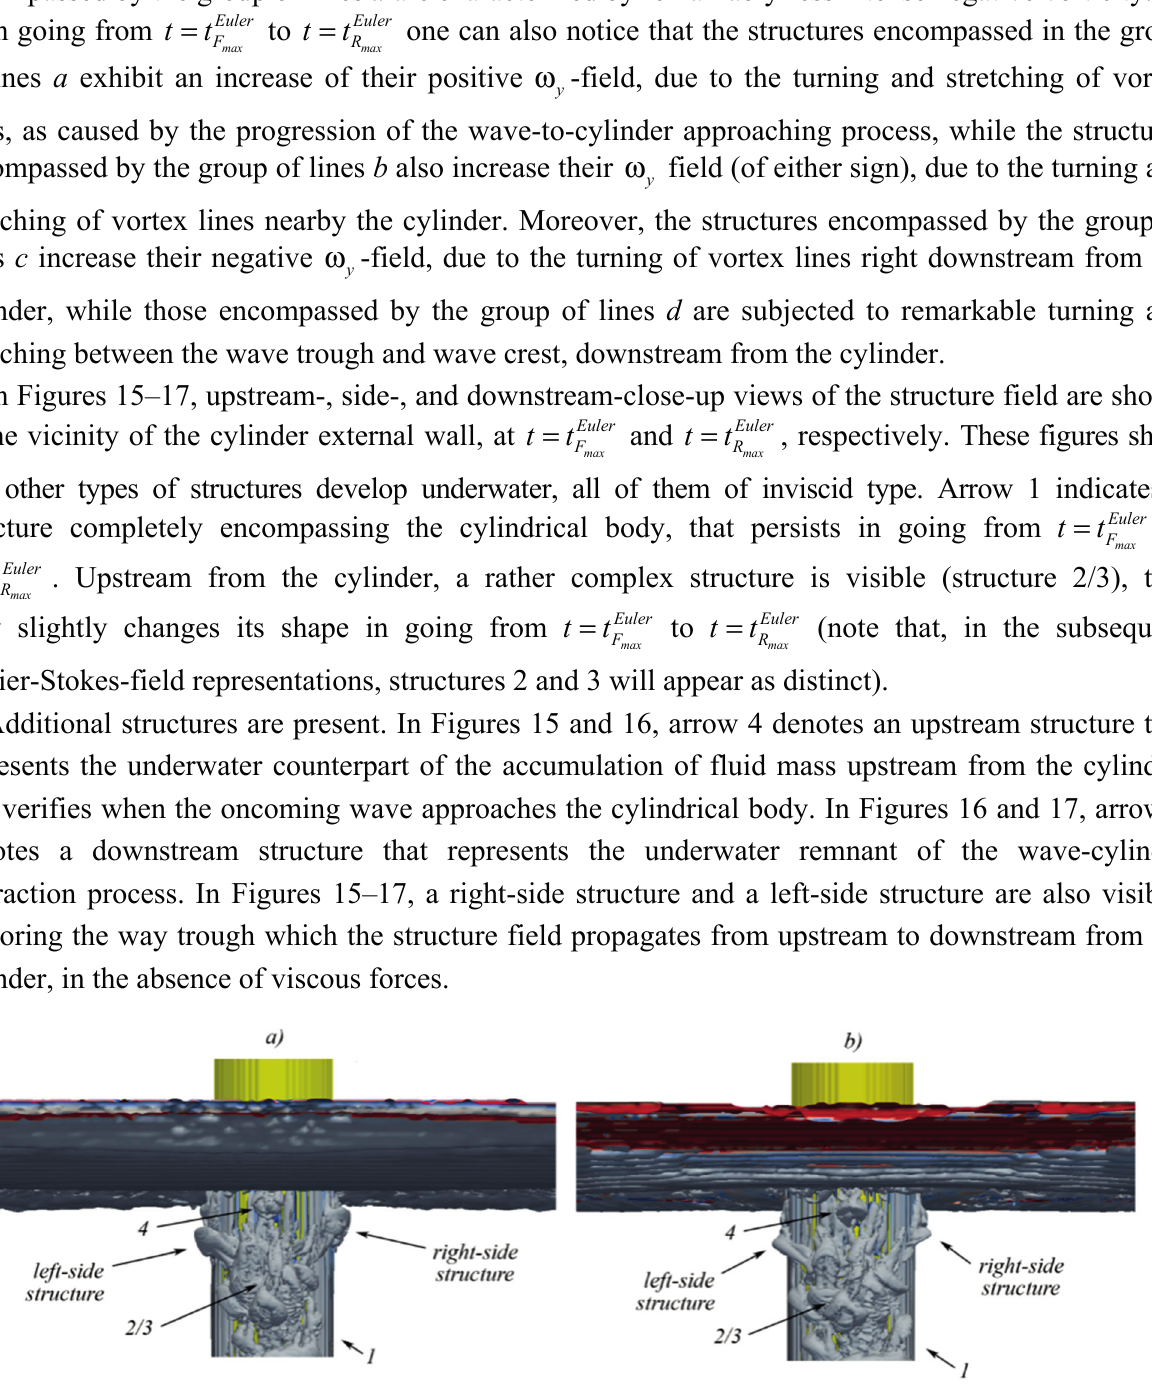
Figure 15. Close-up at the cylinder surface of inviscid-flow structures as obtained from the solution of the Euler equations. Upstream view: ( a